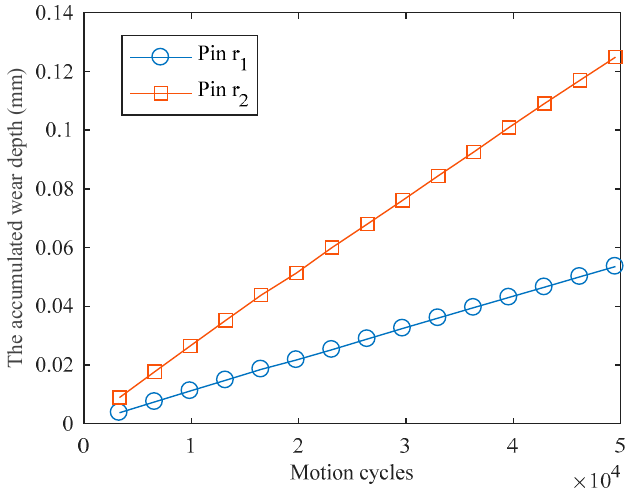
Figure 7. The accumulated wear depth corresponding to different motion cycles.